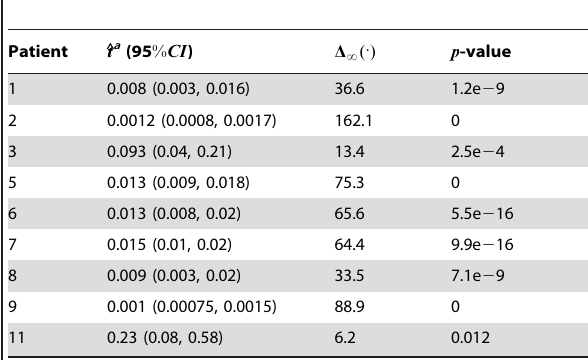
Table 6. The estimates of the seroconversion times ( ^ tt in coalescence units) in the nine patients.